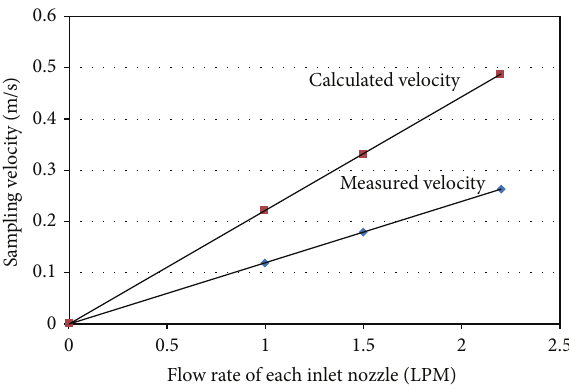
Figure 10: Temperature calibration with LIF